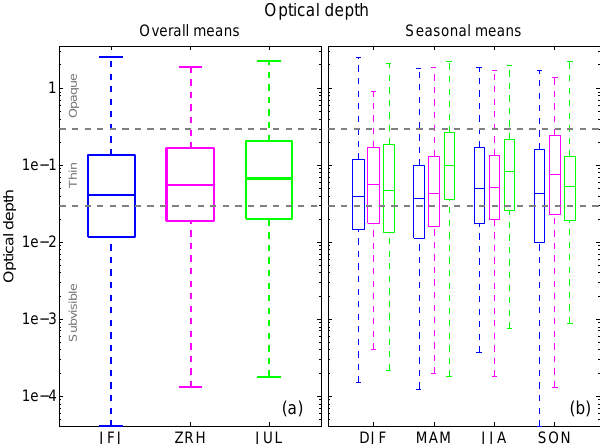
Figure 4. Optical depths of the three measurement sites. (a) Means across whole data set. (b) Seasonal cycle of optical depth. Hor- izontal line in box: median. Boxes: the upper and lower quar- tile. Whisker: extremes. Gray horizontal lines: cirrus categories by Sassen and Cho